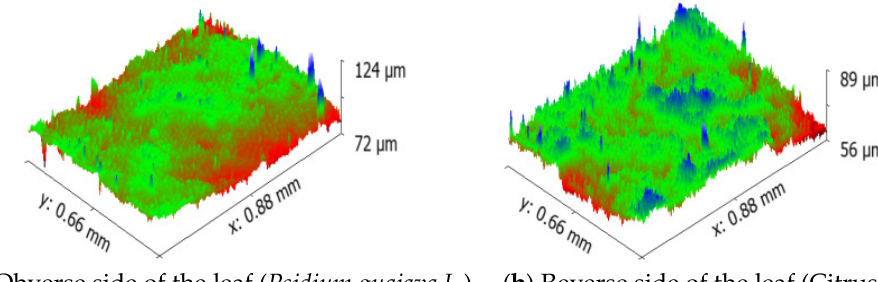
Figure 7. Target leaf surface 3D structures for rough factors in the range of 1.0–1.3.